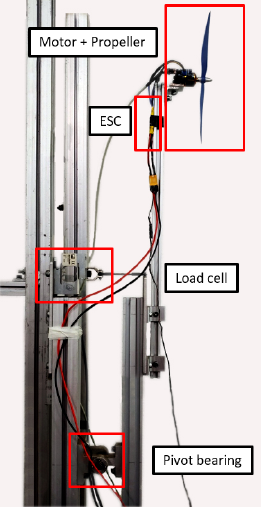
Figure 5. Bench calibration of wind thrust actuator.